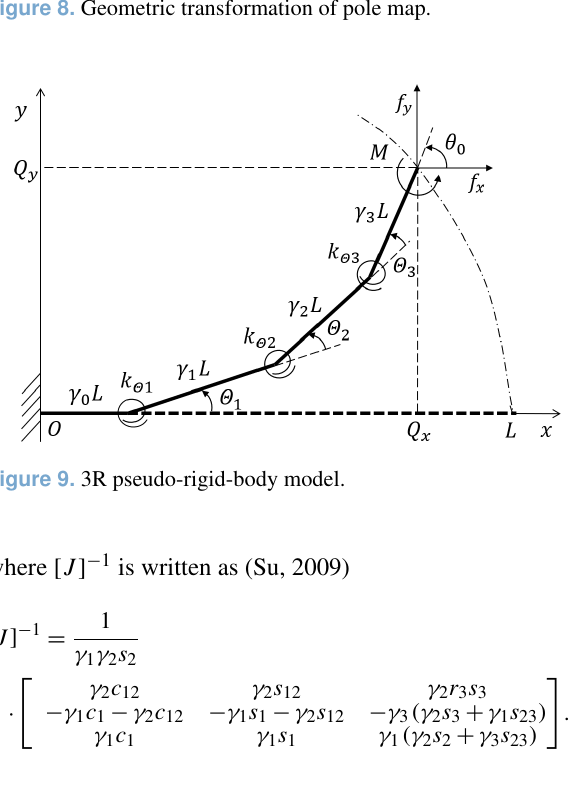
Figure 8. Geometric transformation of pole map.